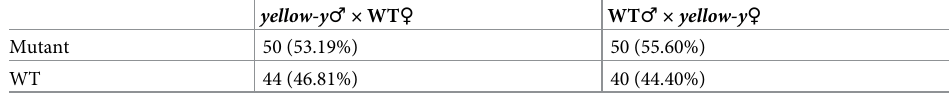
Table 2. The statistical analysis of efficiency for the yellow-y heredity of offspring.